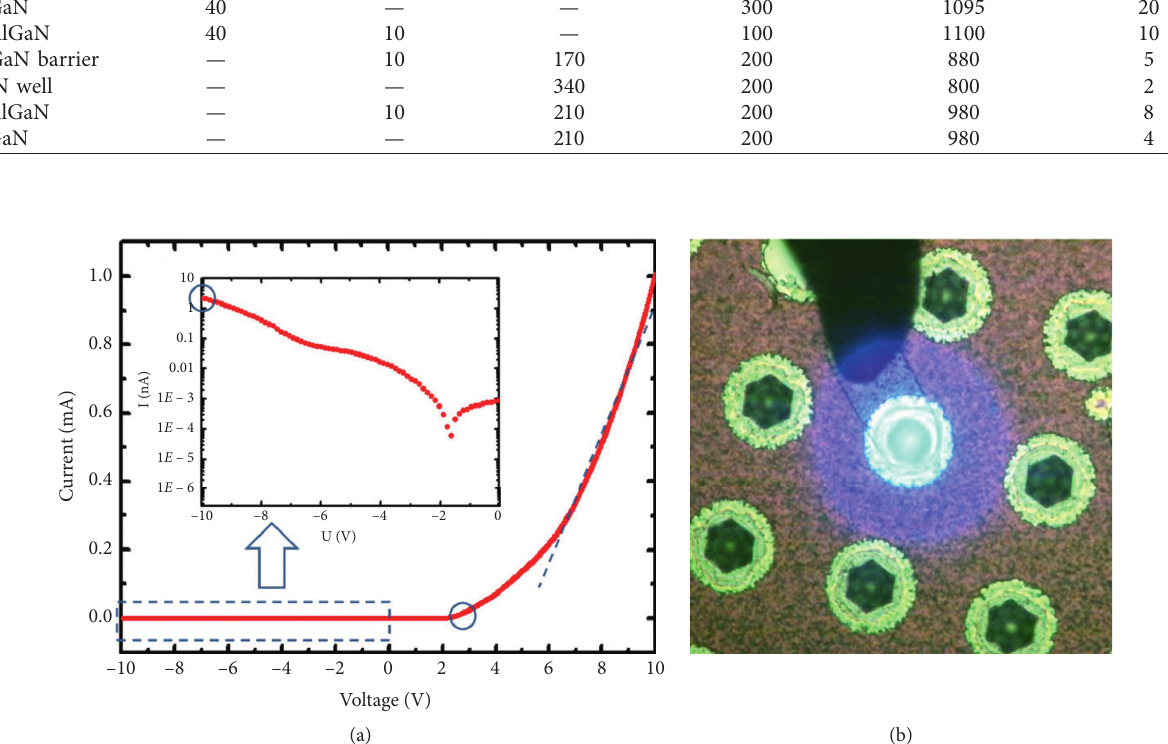
Figure 2: (a) I-V curve and (b) optical microscope photograph of micropyramid UV